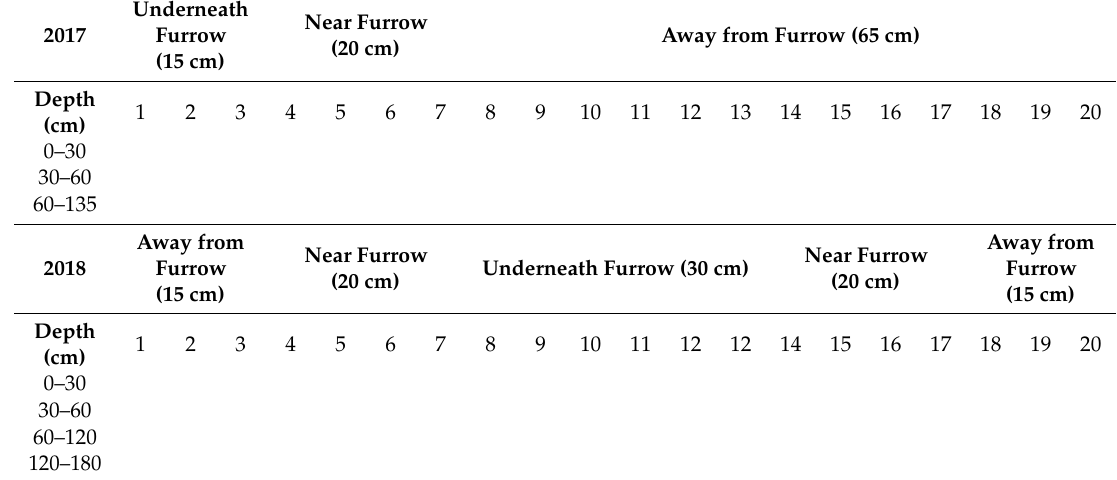
Table 4. Distance classes on the profile wall 2017 and 2018, showing the three categorized distances classes underneath the furrow, near the furrow and away from the furrow and the four depth classes